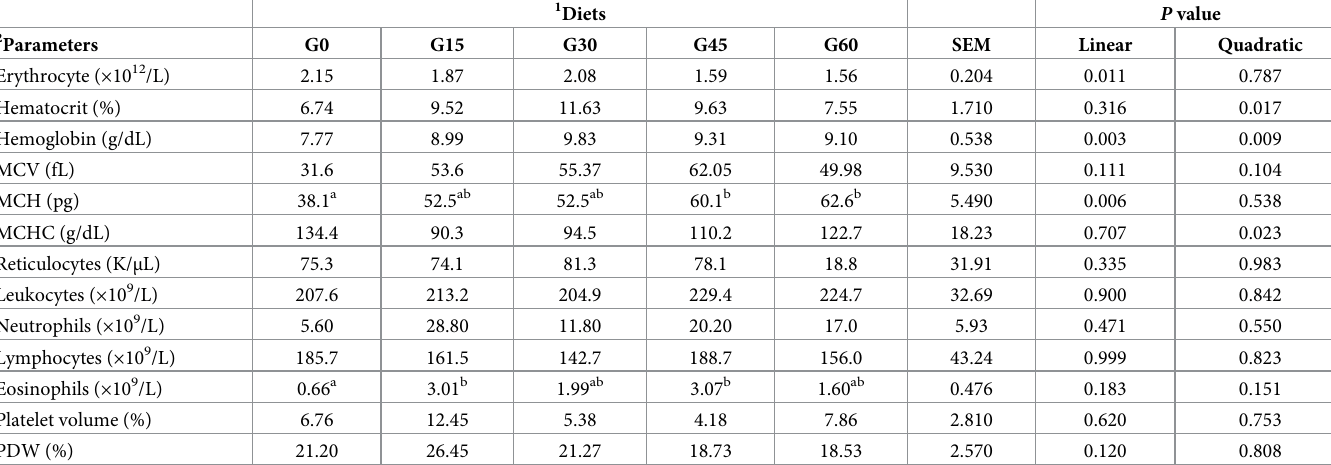
Table 3. Effect of red grape pomace-containing diets on hematological parameters of Hy-Line Silver Brown cockerels.